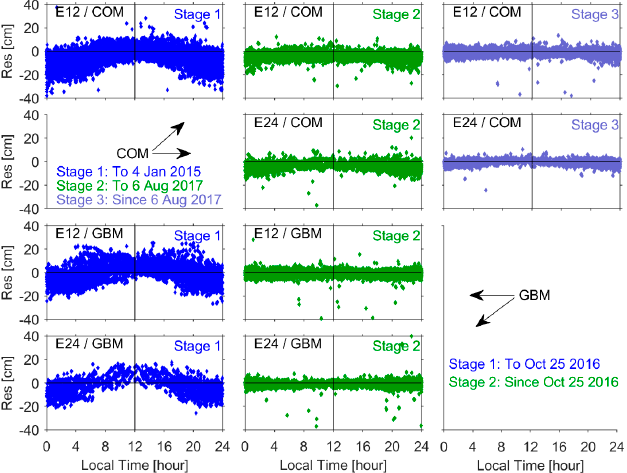
Figure 12. SLR residuals as a function of local time at various tracking sites.